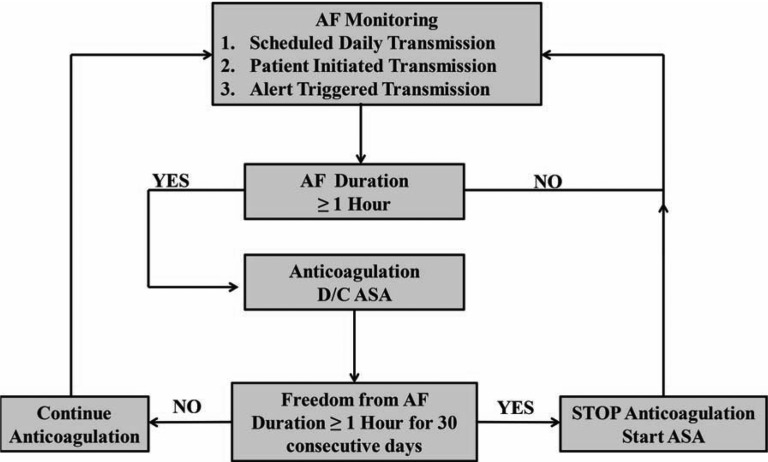
Study schema for the REACT.COM study.26 Reprinted with permission from: Passman R, Leong-Sit P, Andrei AC, Huskin A, Tomson TT, Bernstein, et al. Targeted anticoagulation for atrial fibrillation guided by continuous rhythm assessment with an insertable cardiac monitor: The rhythm evaluation for anticoagulation with continuous monitoring (REACT.COM) pilot study. J Cardiovasc Electrophysiol. 2016 Mar;27(3):264−270. http://onlinelibrary.wiley.com/doi/10.1111/jce.12864/abstract.